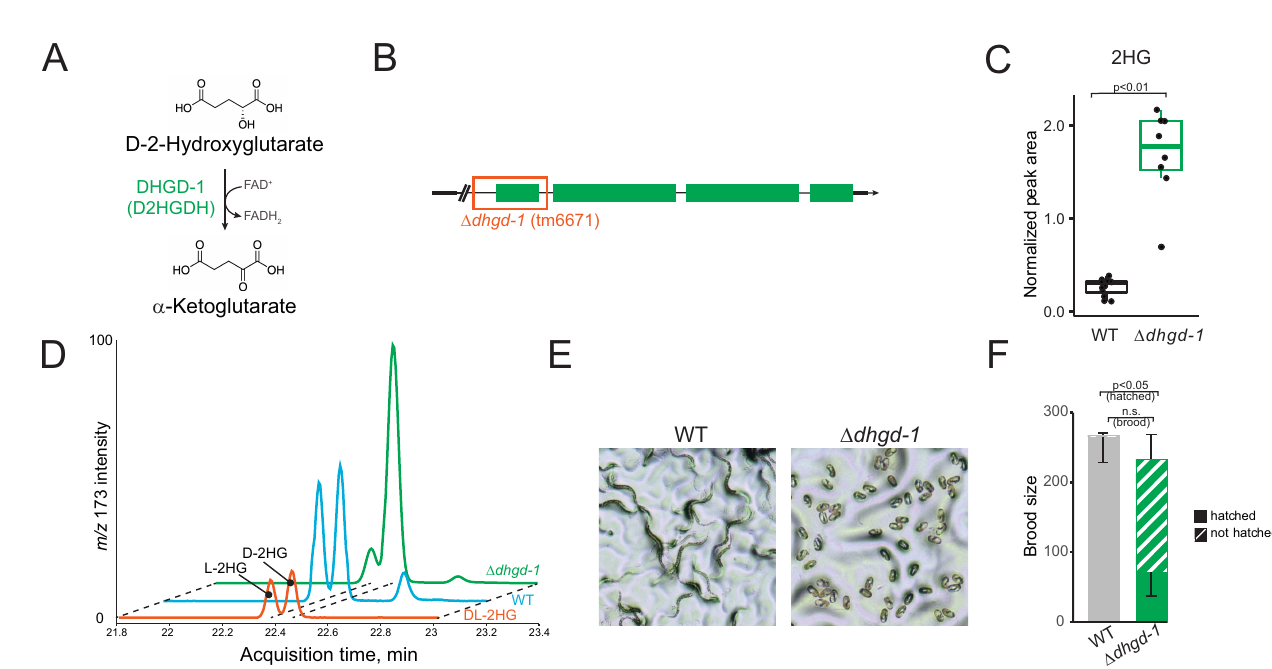
Fig 1. AU : AbbreviationlistshavebeencompiledforthoseusedinFigs 1 to 4 andTable 1 : Pleaseverifythatallentriesarecorrect : Dhgd-1 encodes a D-2HG dehydrogenase. (A) Metabolic reaction catalyzed by D-2HG dehydrogenase. (B) Schematic of deletion in dhgd-1 ( tm6671 ) mutants, referred to as Δ dhgd-1 mutants. (C) GC-MS measurement of 2HG accumulation in Δ dhgd-1 mutants and WT animals. Each dot represents an independent biological replicate. (D) Discrimination between D- and L-2HG enantiomers by chiral GC-MS derivatization in WT and Δ dhgd-1 mutant animals. Raw data are not normalized and therefore do not reflect 2HG concentration in different samples. (E, F) Embryonic lethality and brood size in Δ dhgd- 1 mutants. Brightfield images (E) and hatching (F). Scale bar 50 μ m. Bars in (F) represent mean and standard deviation of n = 3 biological replicates. n.s.–not significant. The data underlying Fig 1C and 1F can be found in S1 Data . D-2HG, D-2-hydroxyglutarate; GC-MS, gas chromatography–mass spectrometry; WT, wild